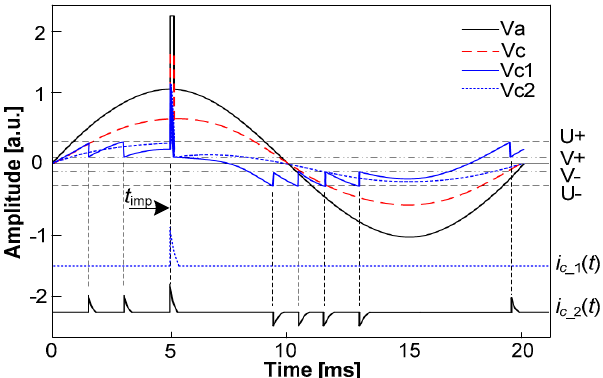
Figure 14. PD model ( left ) and its equivalent circuit ( right ) of PD defect model a or/and e.